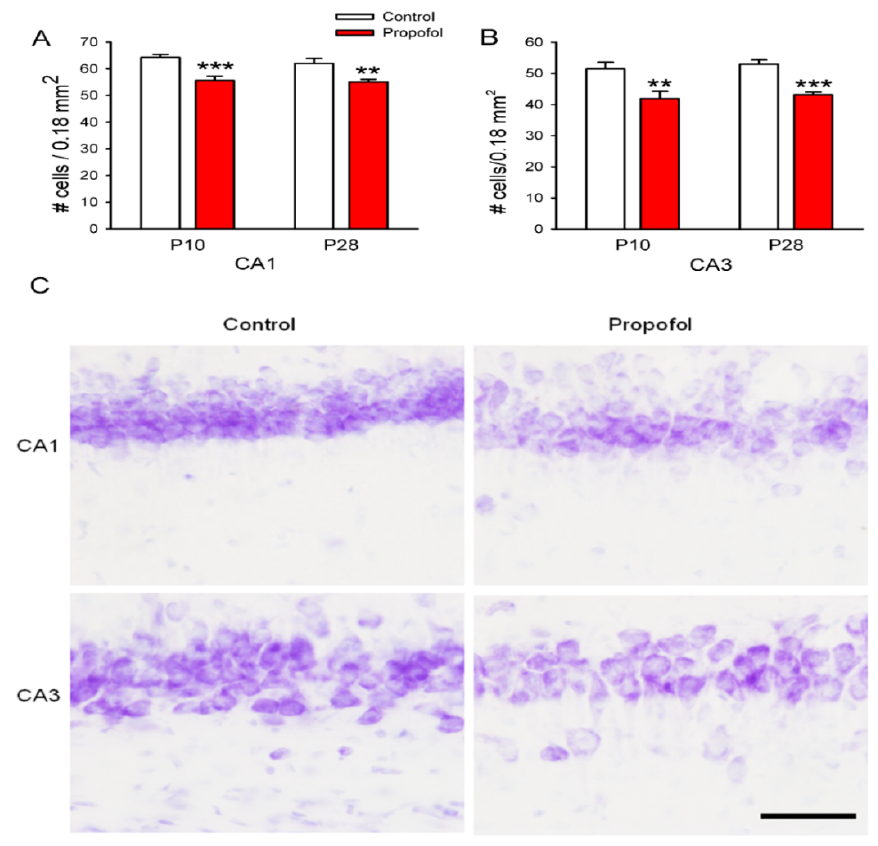
*** p < 0.001 significant difference from age-matched control group. ( C )